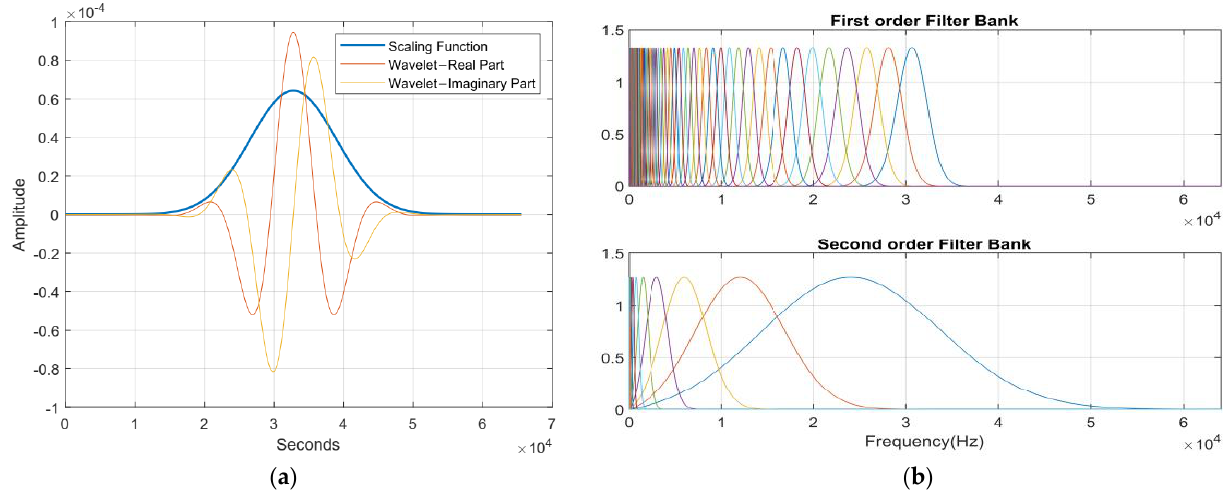
Figure 9. ( a ) The Morlet wavelet and its low − pass filter with a scaling function. ( b ) Frequency response of the first and second filter banks with eight and one wavelets per octave, respectively.